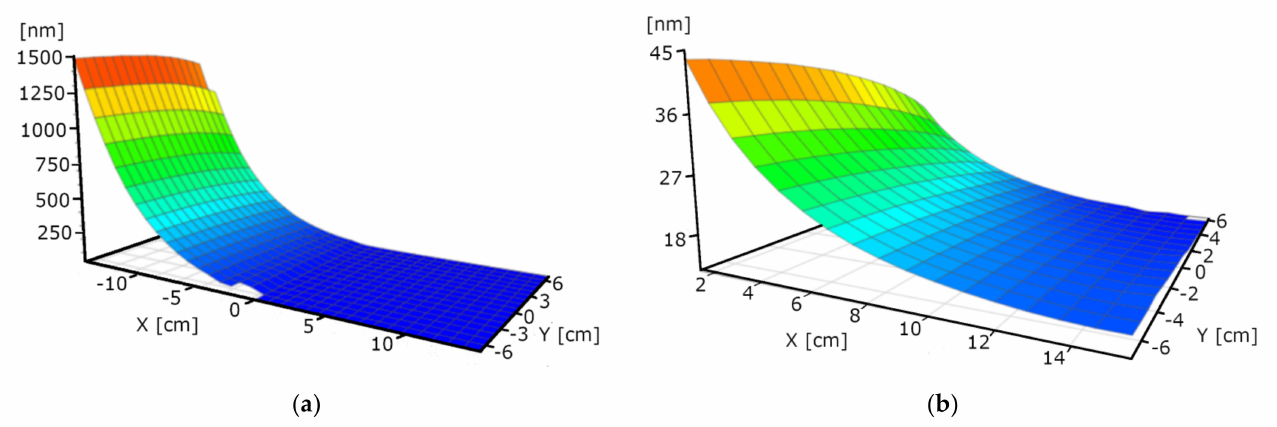
Figure 6. Thickness-maps (in nm) of “W-target only” sample at 1.5 kW power. Maximum thickness value is around 1500 nm. The left map ( a ) shows the middle 15 × 30 cm part, the right map ( b ) shows the thin part with magnified scale (maximum thickness value is around 45